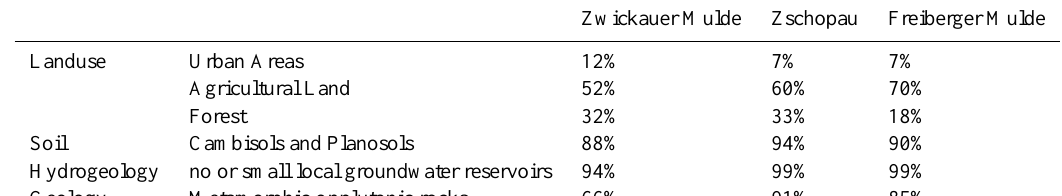
Table 4. Percentages of the dominating landscape characteristics.